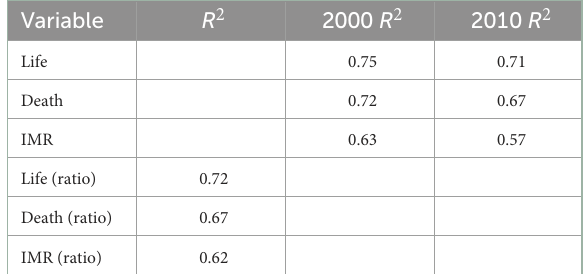
TABLE 4 OLS regression results (ratio); p -value ( p < 0.10). TABLE 5 R 2 and Adjusted R 2 of MGWR